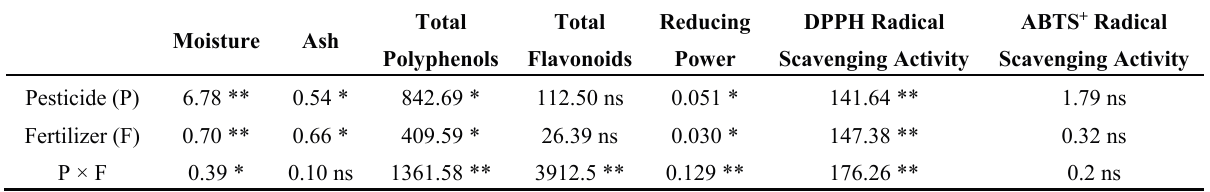
Table 2. ANOVA of Means Square for moisture, ash, phytochemical compound in